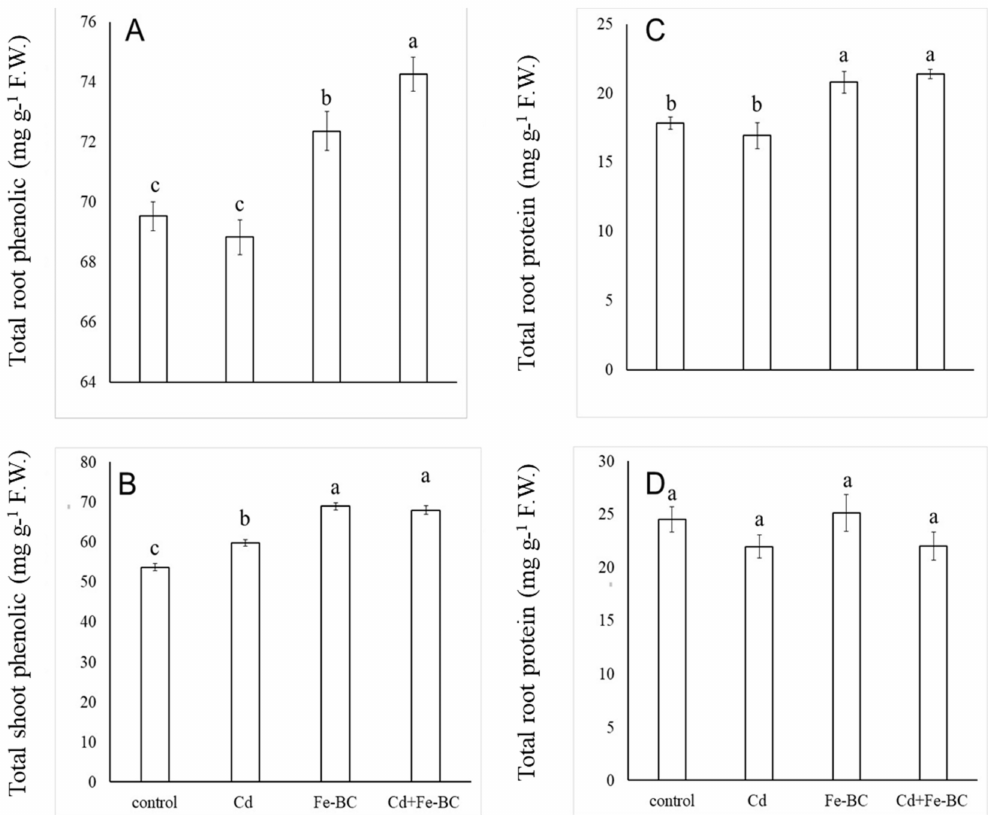
Figure 3. Total root phenolic ( A ) and total shoot phenolic ( B ) (mg g − 1 F.W.) of radish cultivar grown under various treatments (control, Cd, Fe-BC, Cd+Fe-BC). There were three repeats/treatment. Values are the average of three replicates ± SEM. Total root protein ( C ) and total shoot protein ( D ) (mg g − 1 F.W.) of radish cultivar grown under various treatments (control, Cd, Fe-BC, Cd+Fe-BC). There were three repeats/treatment. Values are the average of three replicates ±